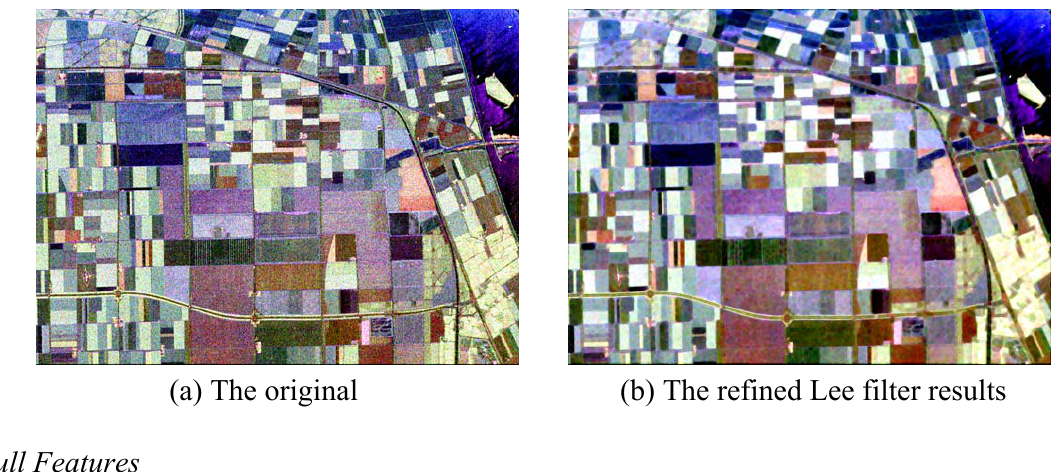
Figure 15. Pauli Image of Flevoland (1024 × 750).